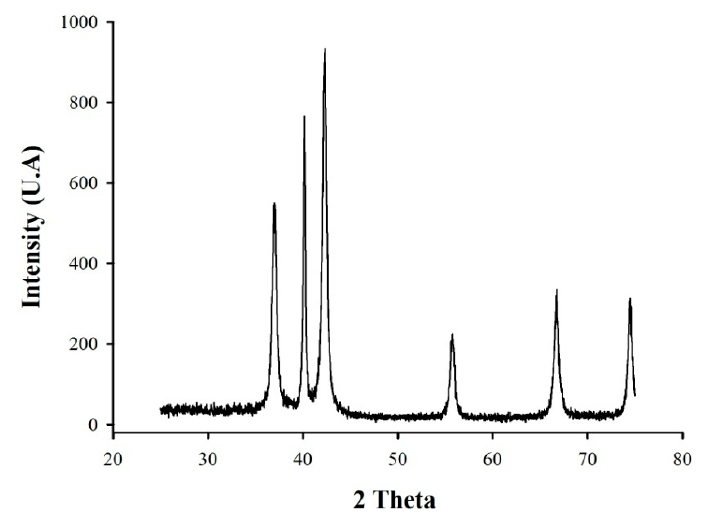
Figure 2. TEM image of the synthetic zinc oxide nanoparticle (Zincite-ZnO NP). Scale bar is 20 nm.